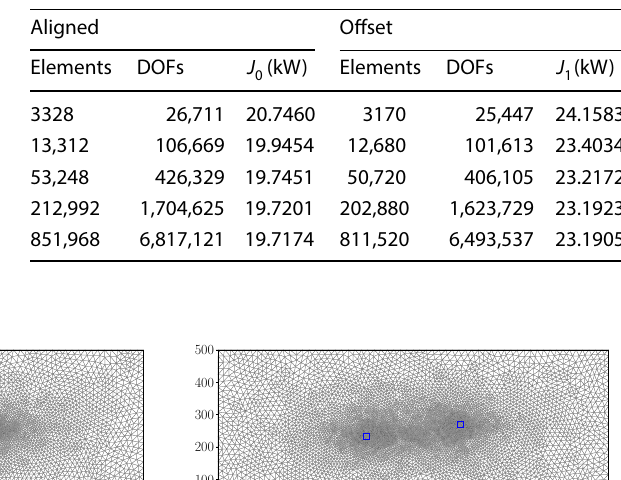
Table 1 Convergence of QoIs J 0 and J 1 evaluated at finite element solutions on a sequence of meshes generated by uniform refine- ment of the initial mesh Aligned Offset Elements